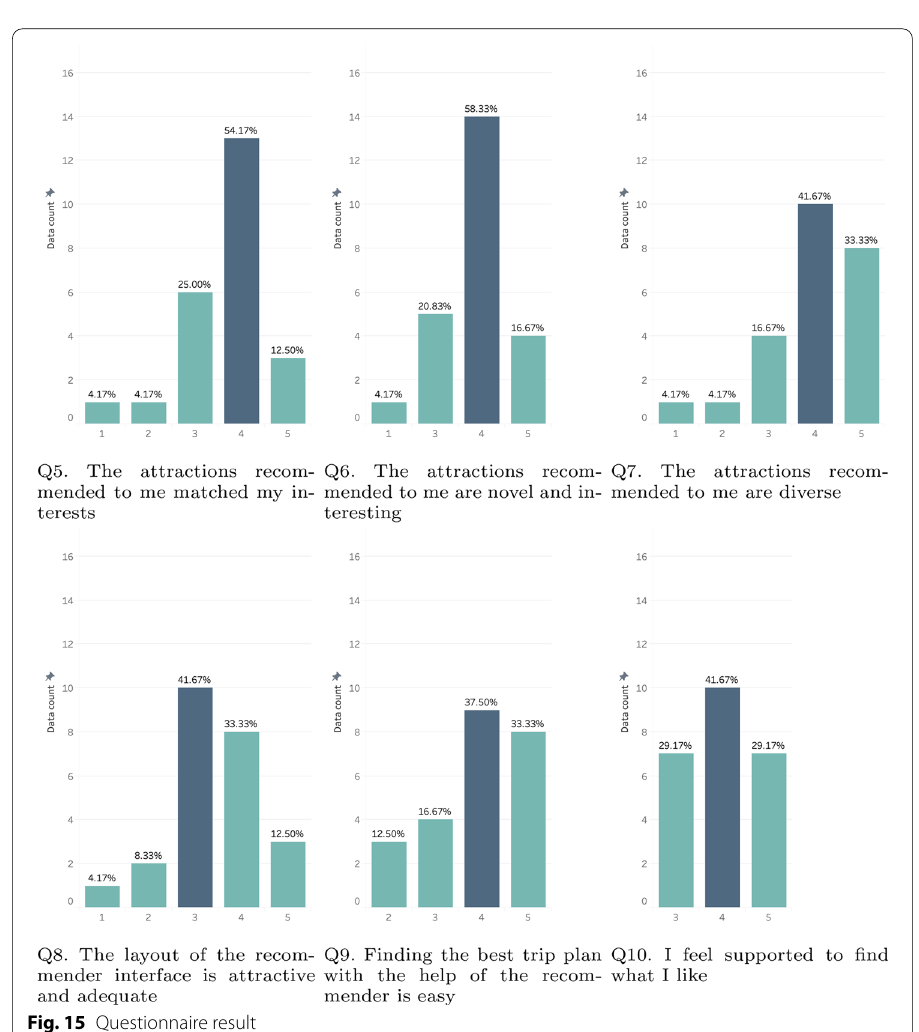
Fig. 15 Questionnaire